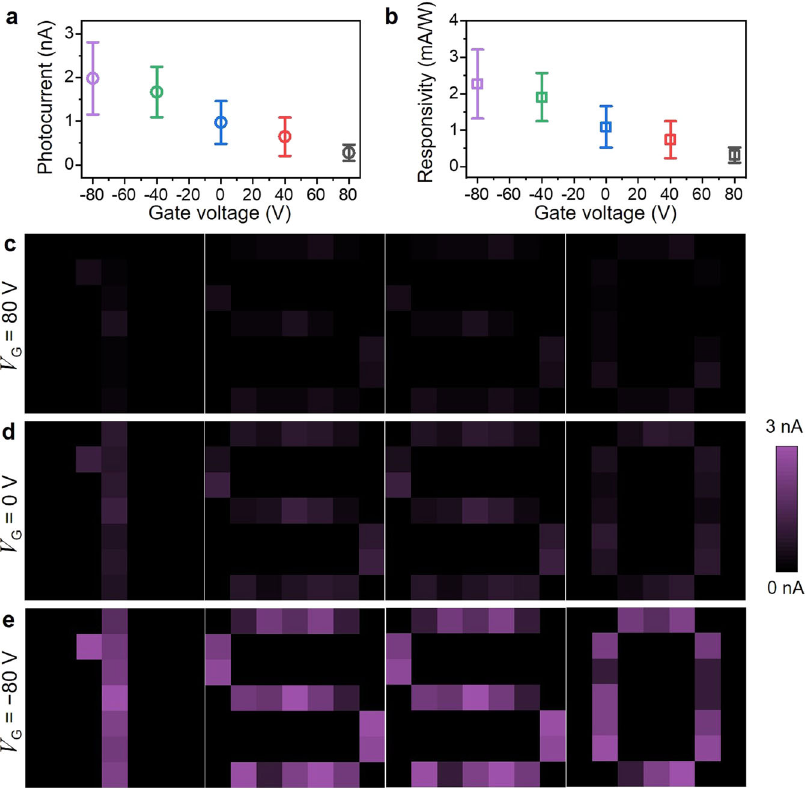
Fig. 4 Image sensing with the BP phototransistor array. a Average photocurrents and b photoresponsivities of the 7 × 7 array of phototransistors at different gate voltages. Error bars represent the standard deviation from 17 – 19 measurements. c – e Photocurrent mapping of a BP phototransistor array under 1550 nm light illumination ( P = 6.84 mW cm − 2 ) at V G = 80 V, 0 V, − 80 V. The drain voltage was fi xed at V D = 1